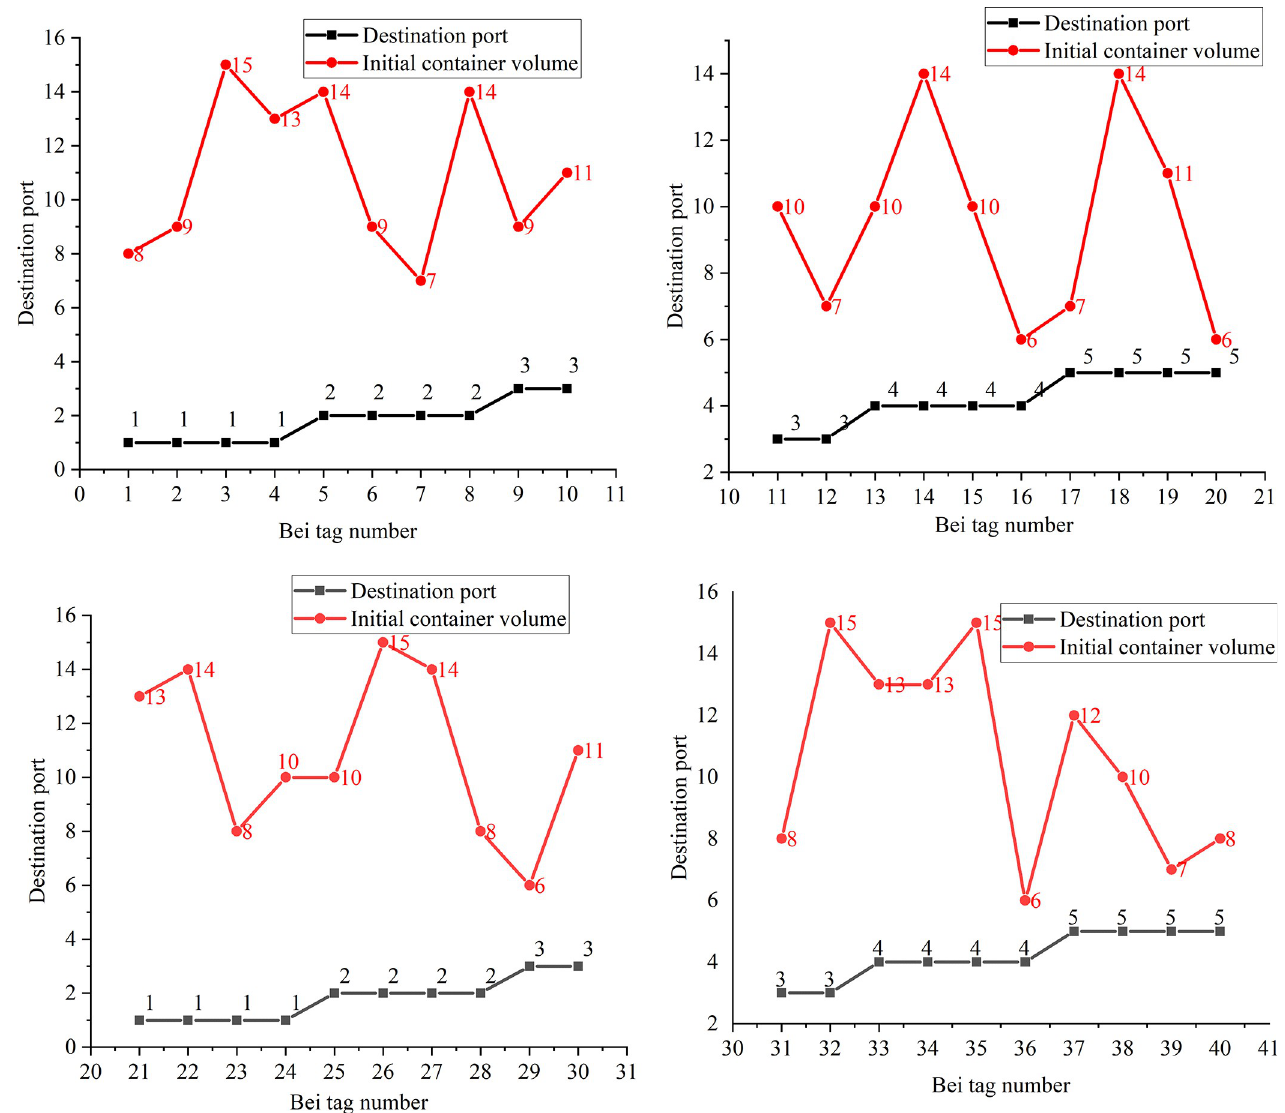
HGSAA algorithm comparison. GA, SAA, and the proposed hybrid algorithm